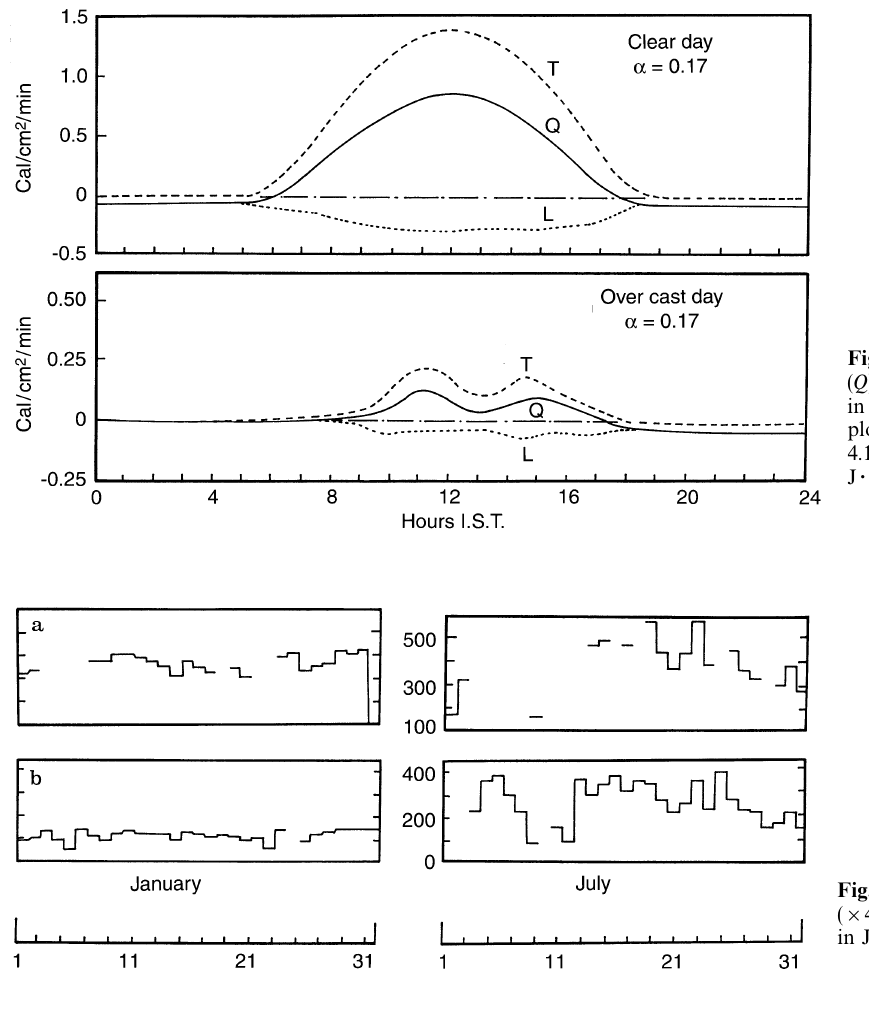
Fig. 2. Global radiation ( „ ), net radiation ( Q ) and net terrestrial radiation ( ‚ ) at Calcutta in Indian Standard Time (IST). The data plotted along the ‰ -axis is to be multiplied by 4.186 (cid:93) 10 (cid:52) to represent the values in J · m (cid:126)(cid:50) · min (cid:126)(cid:49)